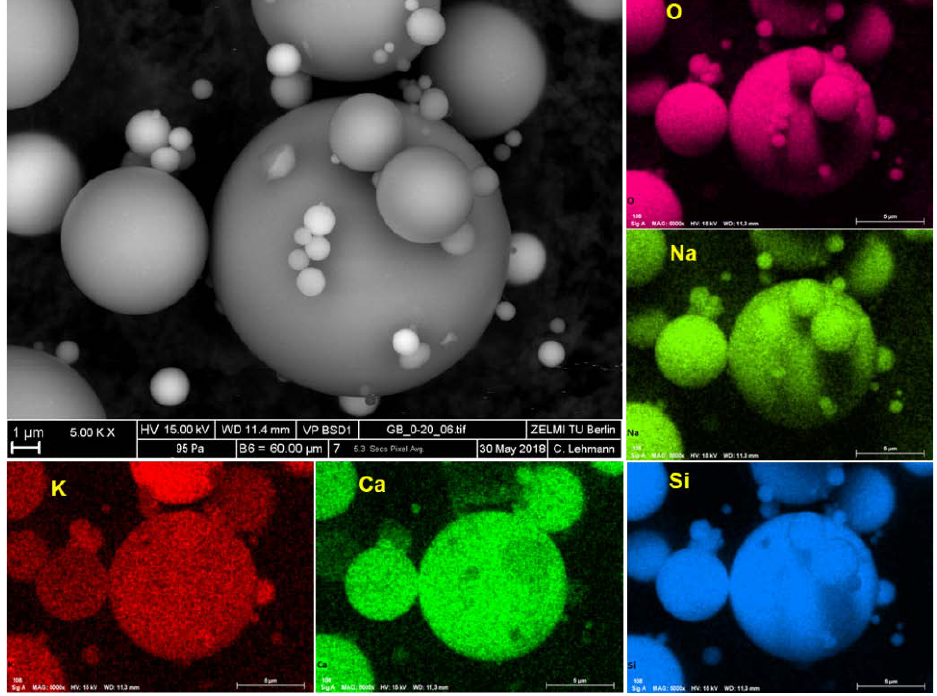
Figure 1. Scanning electron microscope (SEM) pictures of the used glass beads (GB) and the corresponding element analysis.